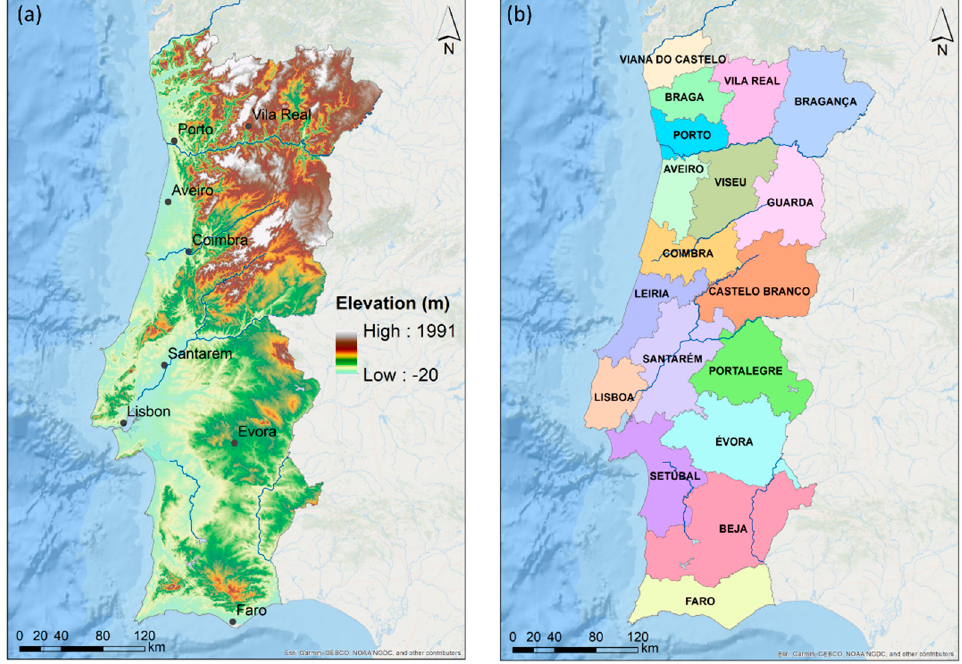
Figure 1. Mainland Portugal ( a ) elevation (in m) and ( b ) the related 18 districts. The land use and occupation maps were retrieved from https://snig.dgterritorio.gov.pt/ accessed on 30 June 2021 [36], for the years 1990, 1995, 2007, 2010, 2015, and 2018.